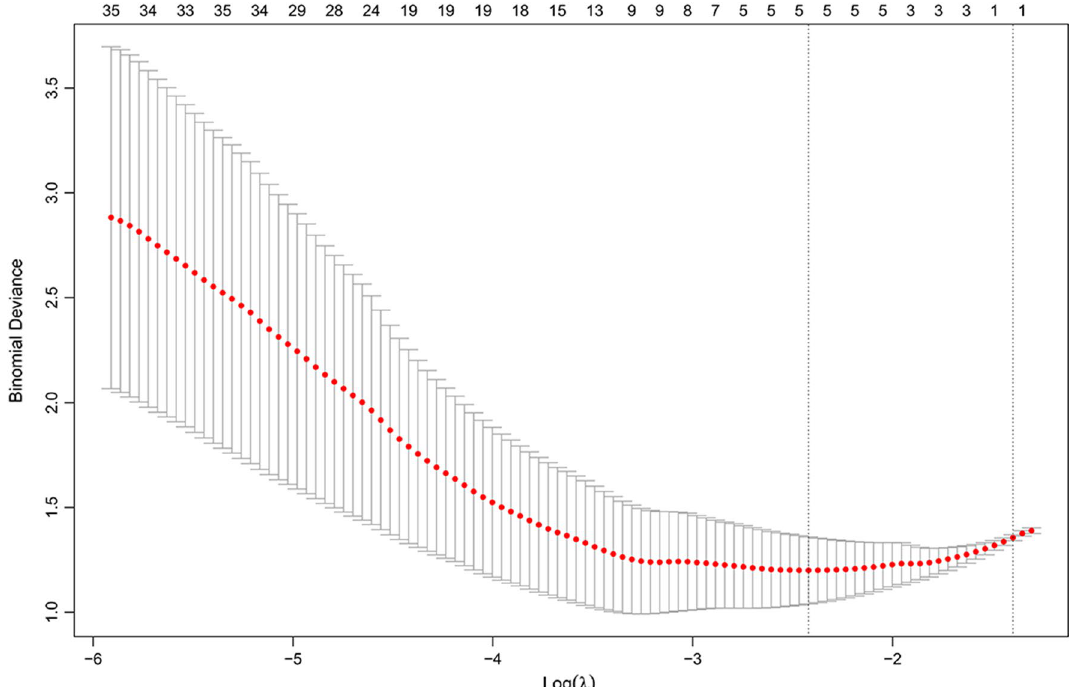
Fig. 3 The radiomics feature selection using the LASSO regression analysis and the ten-fold cross-validation . The abscissa corresponding to the lowest point of the model deviation indicates the optimal penalization coefficient lambda (λ